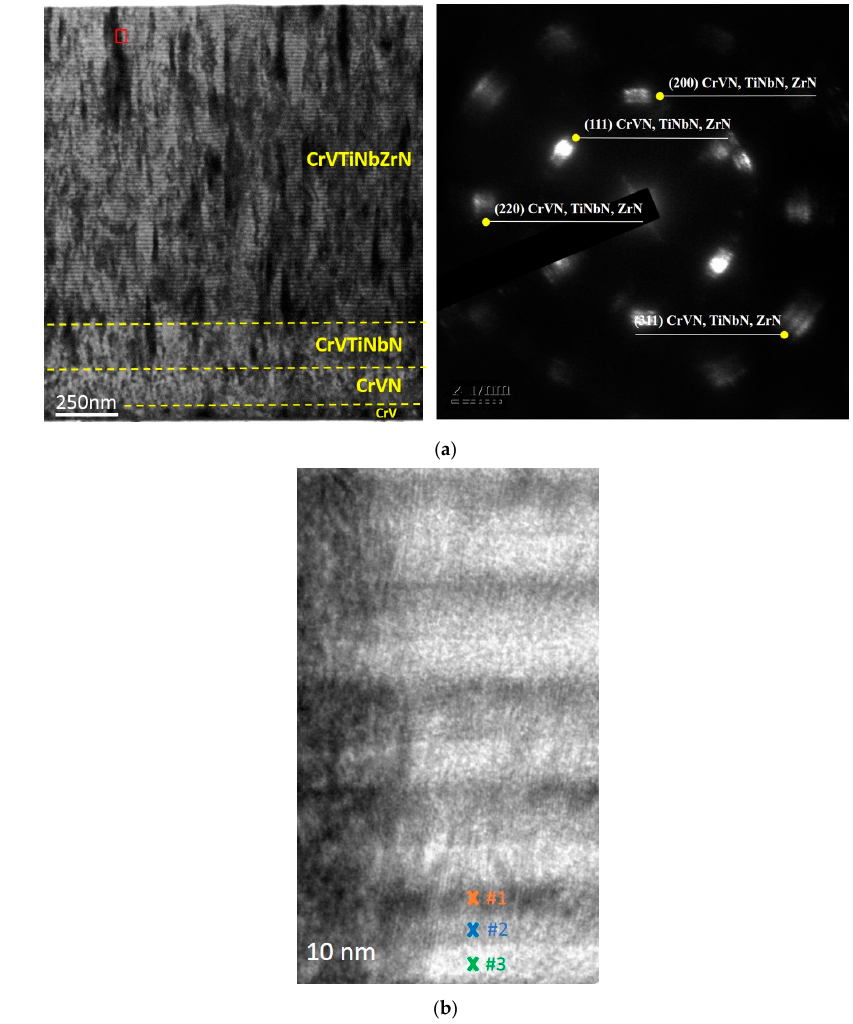
Figure 3. ( a ) Cross ‐ sectional TEM image of the CrVTiNbZrN coating deposited with 165 sccm nitrogen flow rate (HEAN ‐ N165).The right figure shows the corresponding selective area electron diffraction (SAED) pattern of the top CrVTiNbZrN layer. ( b ) Cross ‐ sectional TEM micrograph of the top layer of the HEAN ‐ N165 coating which shows the multilayer architecture of dark layer (ZrN), gray layer (TiNbN) and bright layer (CrVN).